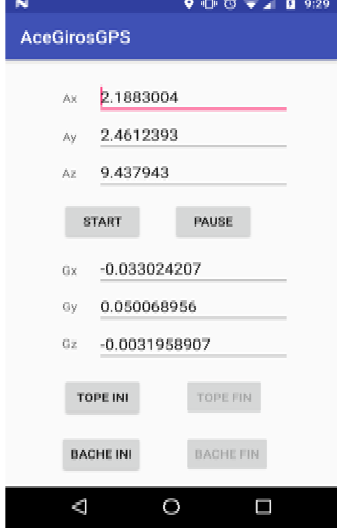
Figure 6 Functionality for marking stops and bumps.